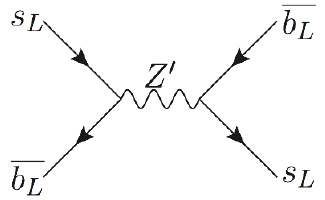
Figure 1 . Feynman diagram of the tree-level Z 0 contribution to B s (cid:0) B s